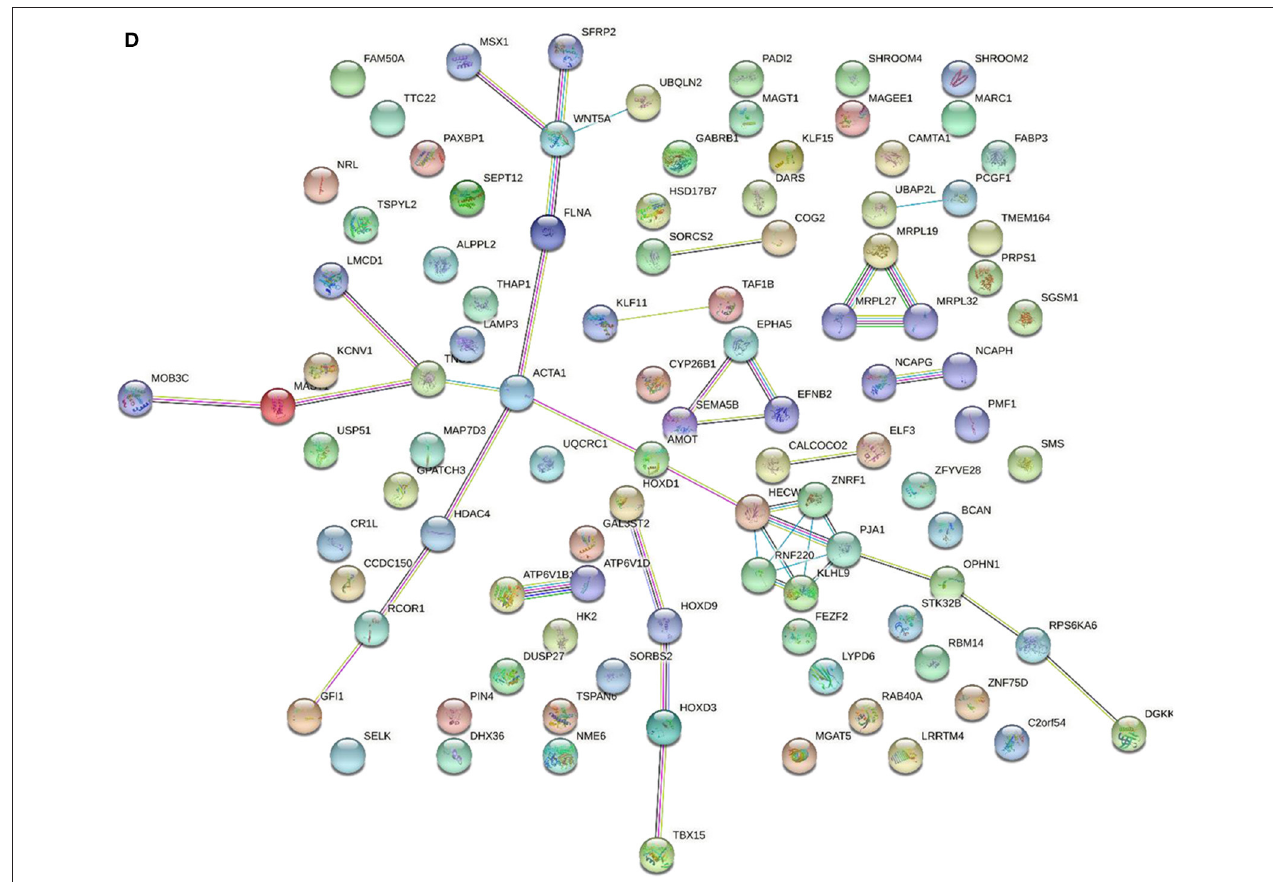
FIGURE 3 | (A) GO enrichment analysis of DMGs. The color intensity of the bars represents the number of enriched genes. (B) GO enrichment analysis of DMGs divided into BP, CC and MF. BP, Biological Process; CC, Cellular Component; MF, Molecular Function. (C) KEGG enrichment analysis of DMGs. (D) The functional protein association network of DMGs obtained from the String